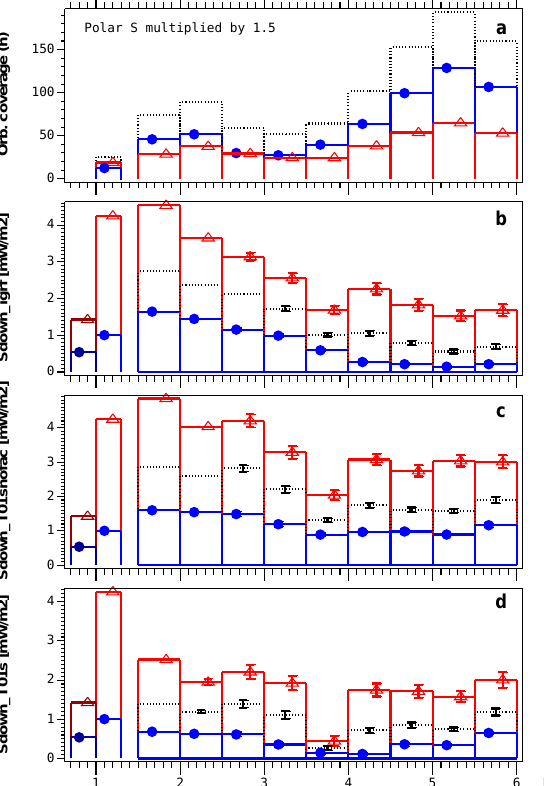
Fig. 2. Statistics of parallel Poynting vectors for the overall night- side auroral oval. Polar orbital coverage as a function of radial (geocentric) distance R in hours with K p ≤ 2 shown as blue solid dots, K p > 2 as red triangles and each K p with a black dotted line (a) , downward AC Poynting vector mapped to ionospheric plane (inmWm − 2 ) for ionospheric scales less than 100km, 200 and 500km (b–d) , respectively, and total downward DC Poynting vec- tor with T01 NOFAC model field subtraction (e) . In panels (b–e), dark-blue and reddish bar at R = 0 . 7 − 1 is electron precipitation power per area from the Hardy et al. (1987) model for low K p ( ≤ 2) and high K p ( > 2), respectively. In panel (e), blue and red bar at R = 1 − 1 . 3 is DC Poynting vector from Astrid-2 satellite (1000km altitude) from Olsson et al. (2004a) and in panel (a), the correspond- ing bar shows the orbital coverage of Astrid-2. To compensate for the fact that only the spin-plane components of Polar electric field are used, all measured Polar Poynting vectors are multiplied by 1.5 (see text for motivation).